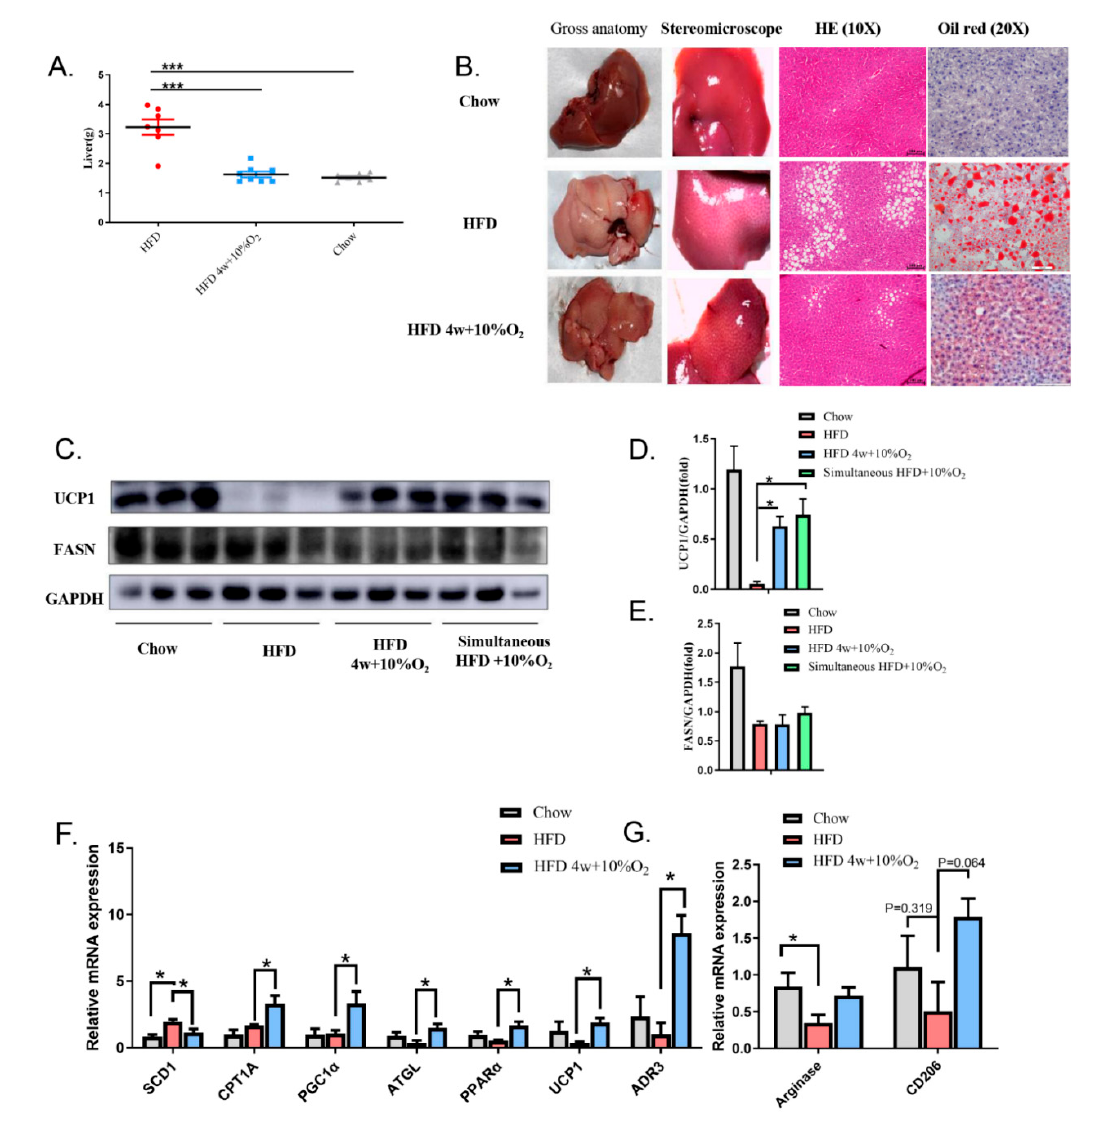
Figure 3. Hypoxia alleviates fatty liver and alters the expression of fatty liver markers. ( A ) Livers were isolated from indicated groups of mice and weighed (mean ± SEM, n = 8). *** p < 0.005. ( B ) Representative images of gross liver, H&E (10 × ), and Oil Red O staining (20 × ) are presented. ( C – E ) Liver extracts were blotted with antibodies against UCP1 and FASN. Bands were quantified by ImageJ and normalized by GAPDH. ( F , G ) Expression of selected genes for ( F ) lipid metabolism, mitogenesis, and thermogenesis, and ( G ) M2 markers for macrophages in the liver were examined by qPCR, and the signals were normalized by 18S rRNA . Significance was tested by Student’s t -test (mean ± SEM, n = 3), * p <